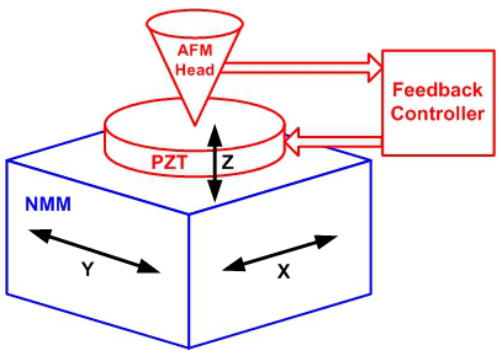
Figure 5. The measuring mode of the AFM